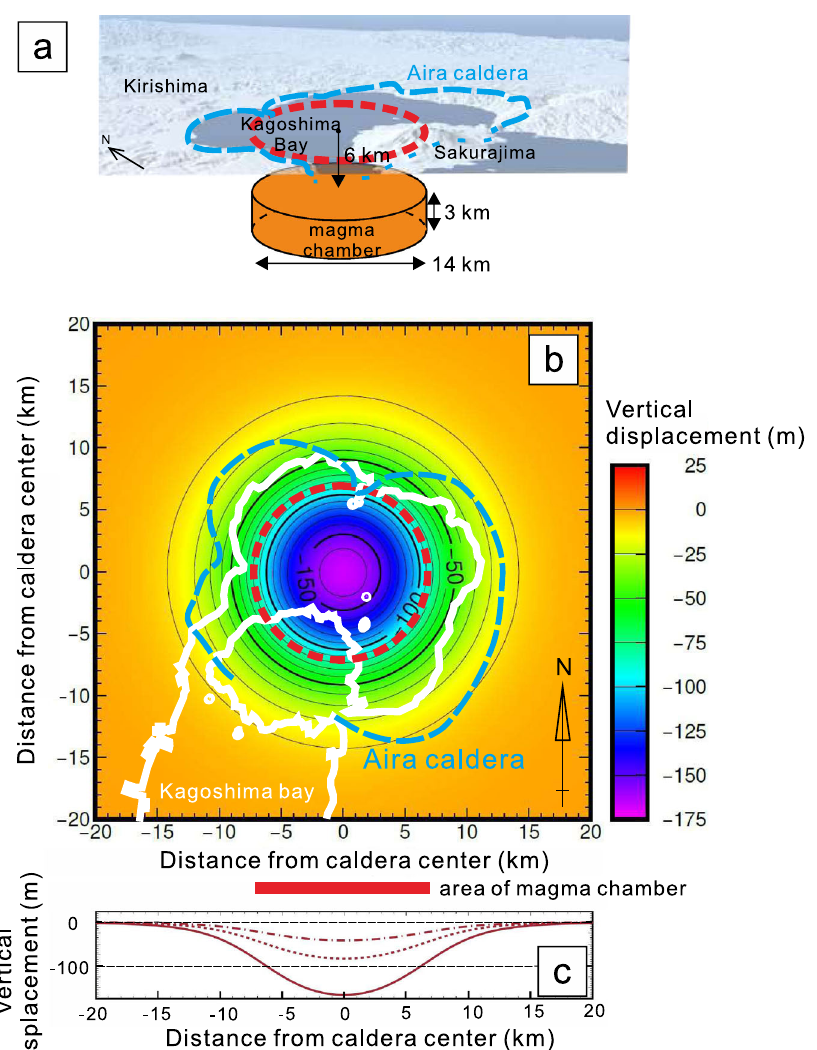
Fig. 5 Con fi guration and results of modeling deformation during caldera collapse. a Outline of the con fi guration of the model. A cylindrical magma chamber with a horizontal diameter of 14 km and a vertical length of 3 km at the depth of 7 km from the ground surface is assumed for the simulation. The magma chamber is centered on the center of the Aira caldera. Broken red line shows the projection of the magma chamber to the present sea level. Broken blue line is the current topographic caldera rim. b Calculated vertical displacement of ground surface at the end of the eruption of the Osumi pumice fall due to the 40-km 3 extraction of magma from a magma chamber beneath the Aira caldera. The minus sign indicates subsidence. The contour interval is − 10 m. Broken red line and blue line mark the projection of the magma chamber to the present sea level, and the topographic caldera rim, respectively. White solid line shows the current coastline. c The vertical displacement pro fi le as a function of the distance from the deformation center after the extraction of magma from the chamber with a volume of (dashed and dotted) 10, (dotted) 20, and (solid) 40 km 3 . The inverted triangles mark the distance corresponding to the perimeter of the magma